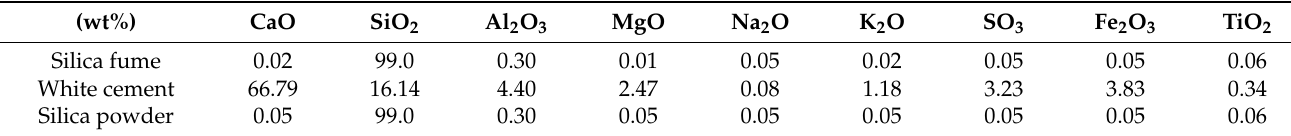
Table 2. Chemical composition of